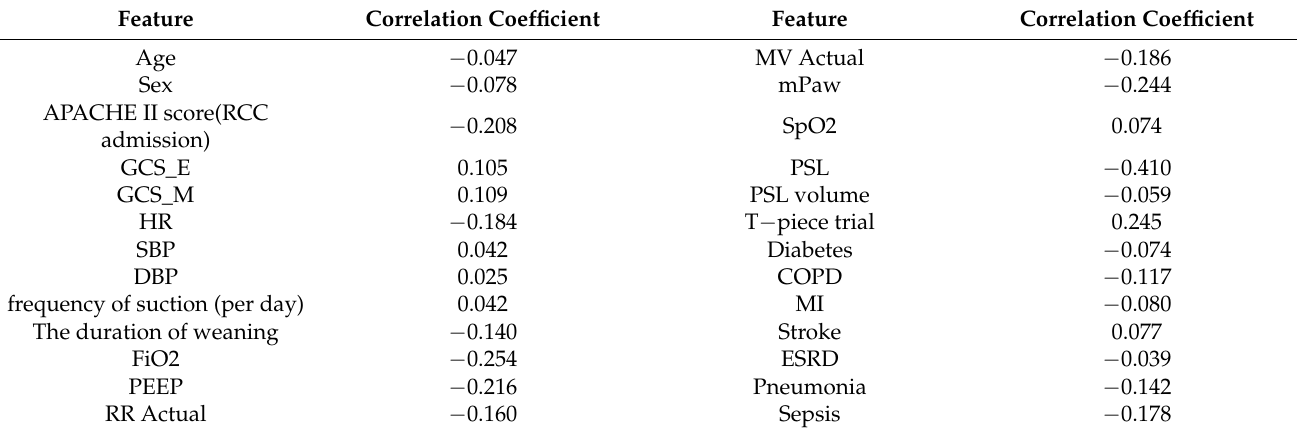
Table 2. The correlation coefficient between each feature and outcome of successful weaning.